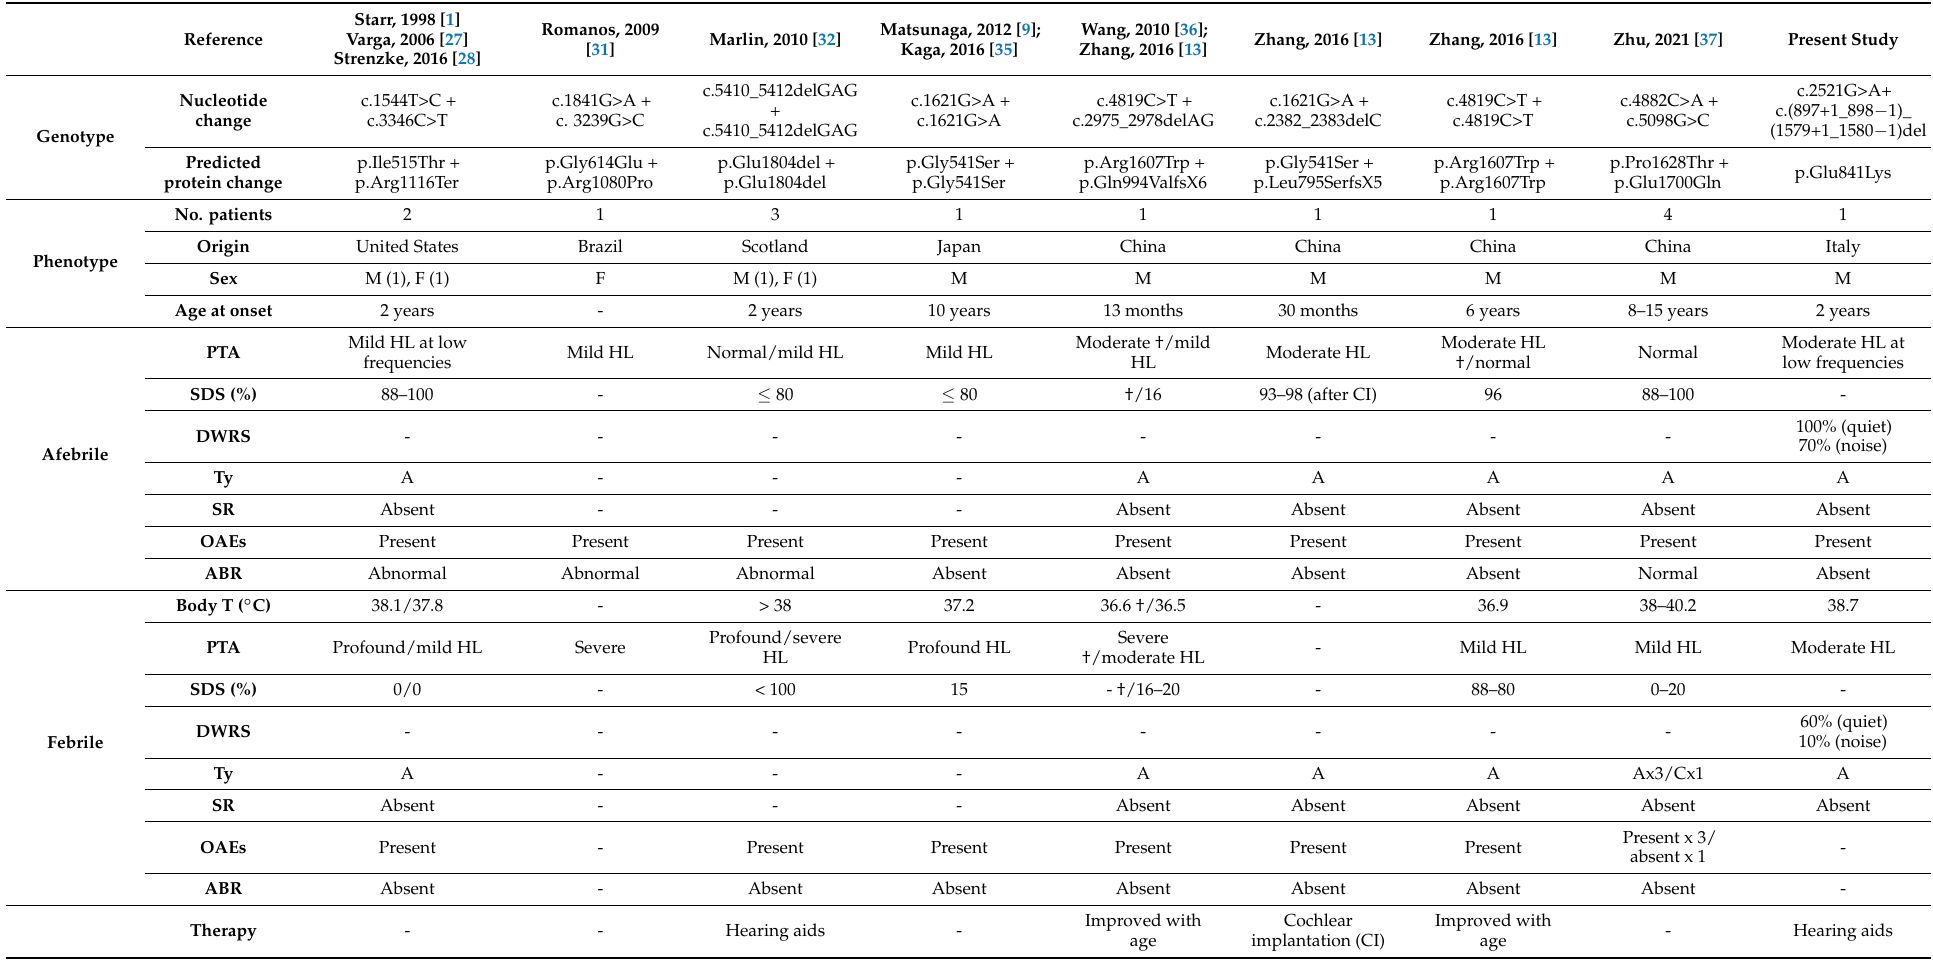
Table 1. Overview of genotype–phenotype correlations of OTOF variants in patients affected by TS-ANSD in the present study and in previous studies. PTA, pure-tone audiometry; SDS, speech discrimination score; SR, stapedial reflex; OAEs, otoacoustic emissions; ABR, auditory brainstem response; Ty, tympanometry; DWRS, disyllabic word recognition score; † before hearing